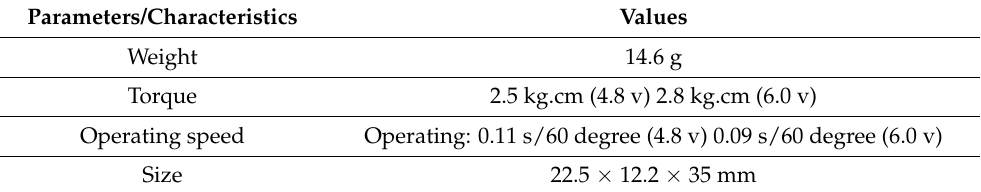
Figure 4. Block diagram used during simulation by ISIS.